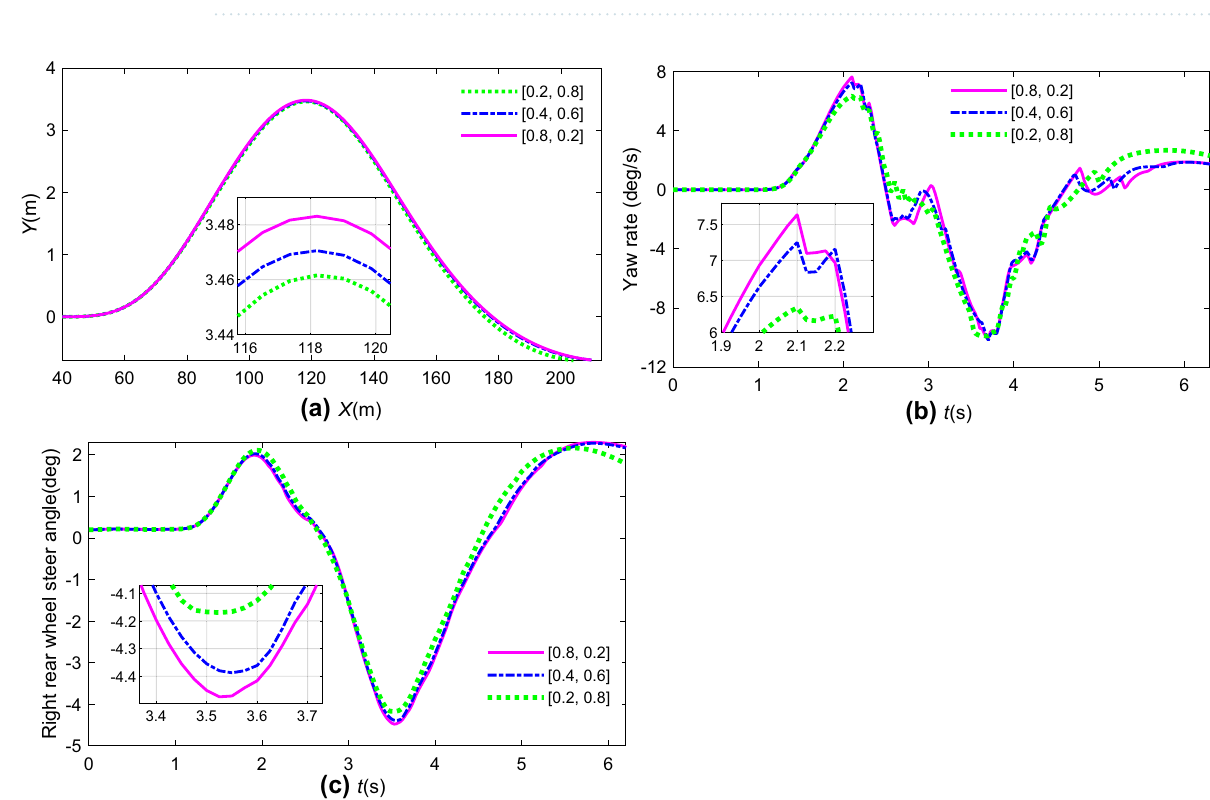
Figure 12. State response comparison by different controllers: ( a ) path tracking; ( b ) path tracking error; ( c ) yaw rate; ( d ) rear steering angle.